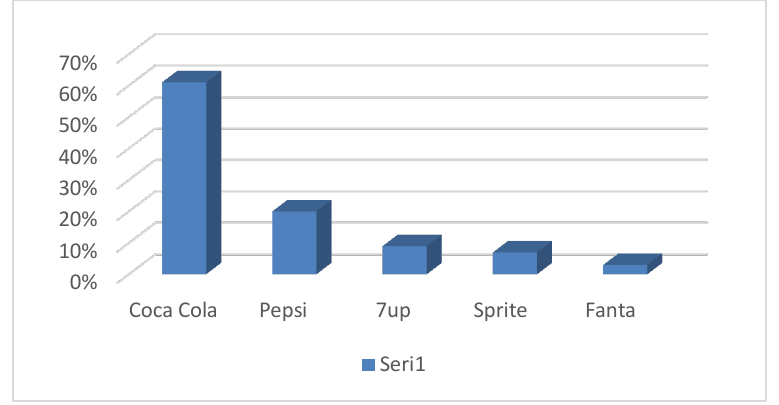
Figure 8: Advertisement of which drink do you remembers the most?